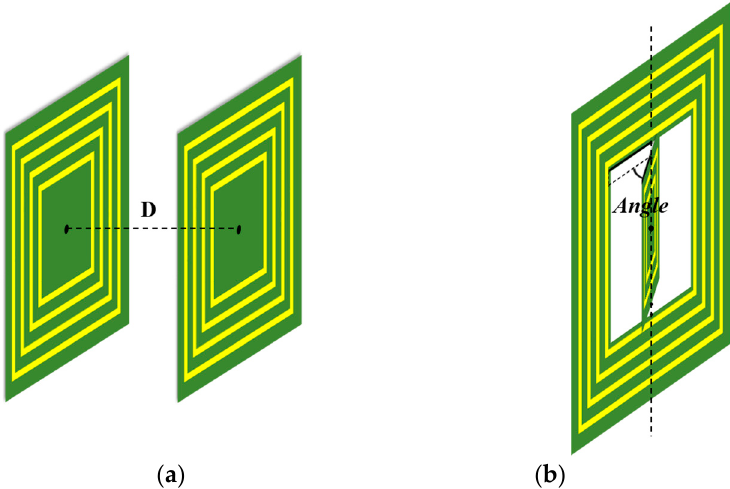
Figure 5. Relative position relation of coils, ( a ) parallel coaxial coils, ( b ) concentric coils.